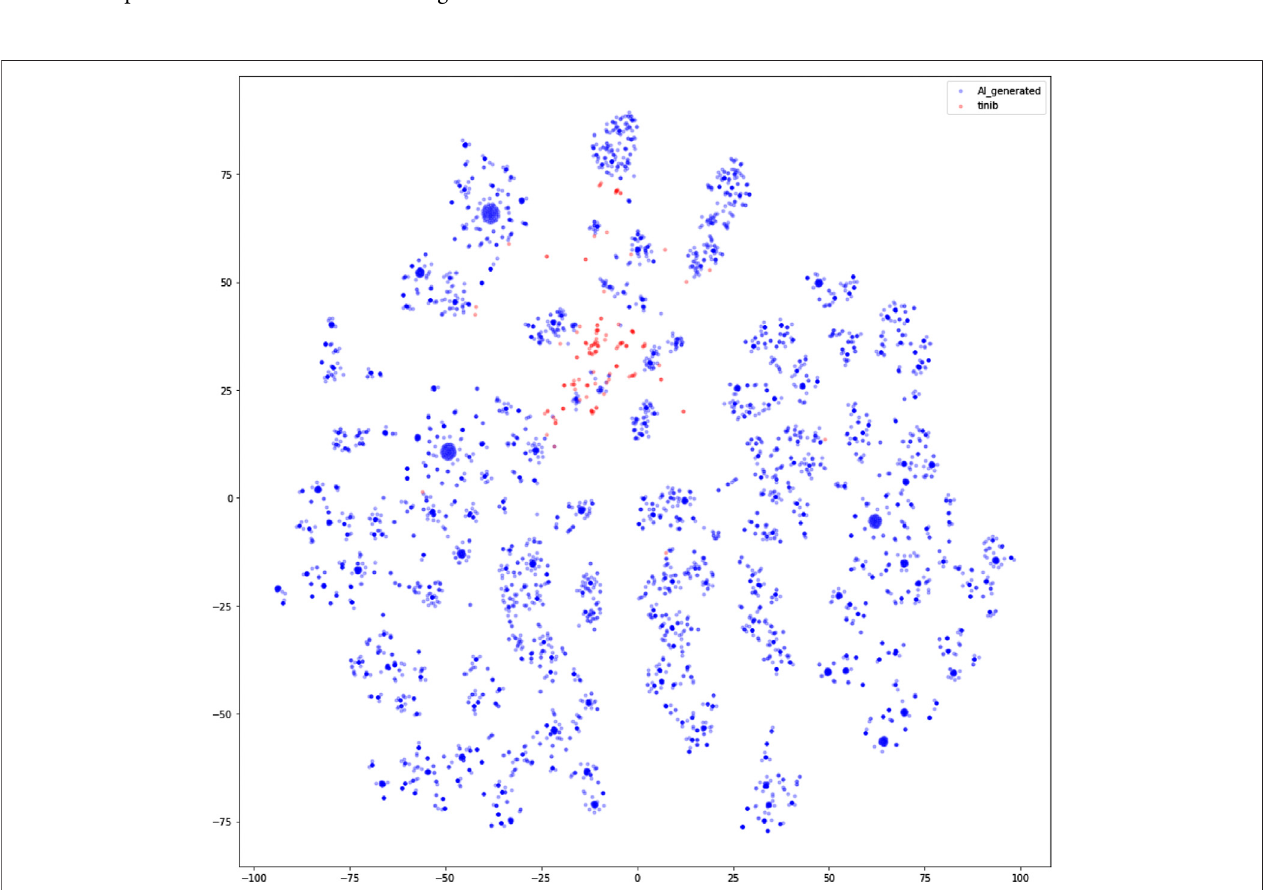
FIGURE 2 | Two-dimensional representation of ‘ − tinib ’ and AI-generated ligands using t-SNE.